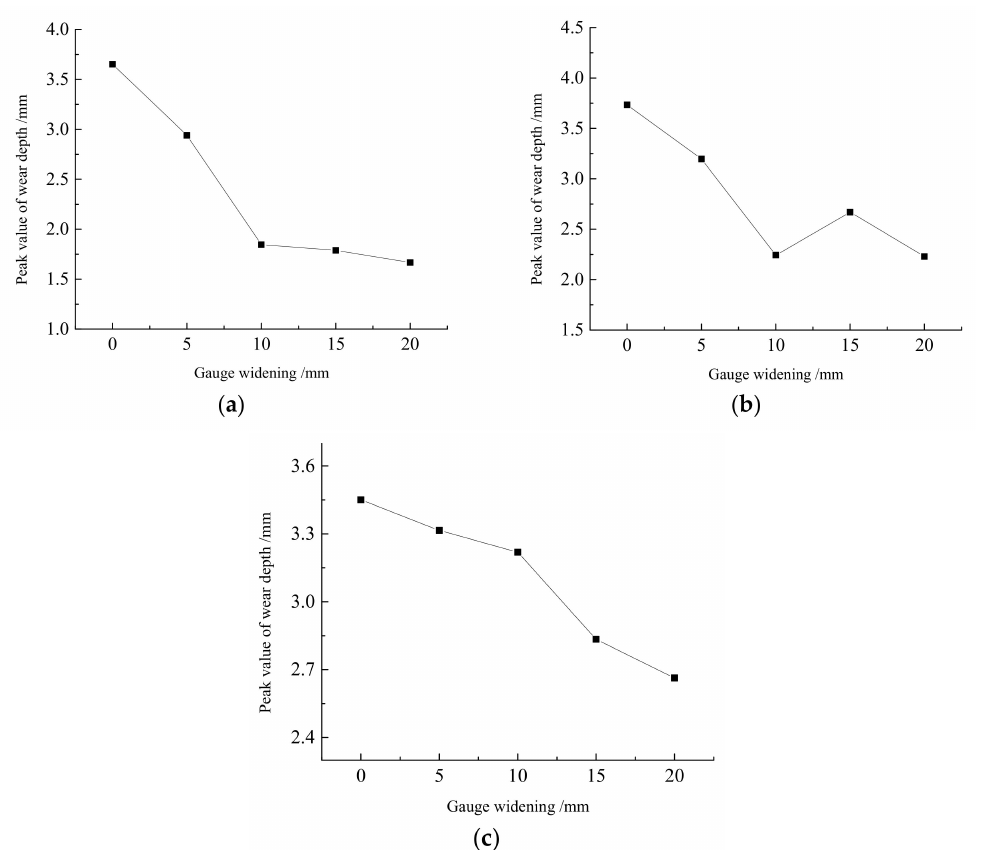
Figure 16. Influence of gage widening on rail wear amplitude: ( a ) 350 m; ( b ) 300 m; and ( c ) 250